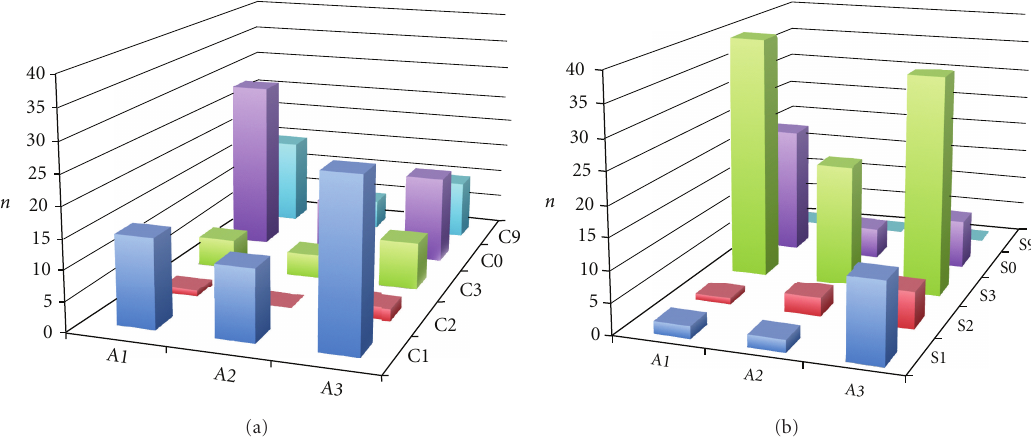
Figure 1: ASCO classification of stroke etiologies. The ASCO classification for “A” (atherothrombosis), “S” (small vessel disease), and “C” (cardioembolic). The “O” (other causes) group was omitted because only 4 patients received a grade other than “0.” As all patients had Duplex/Doppler imaging and carotid stenosis, no patient had “A0” or “A9,” so these groups were omitted. The figure visualizes competing/coexisting etiologies.